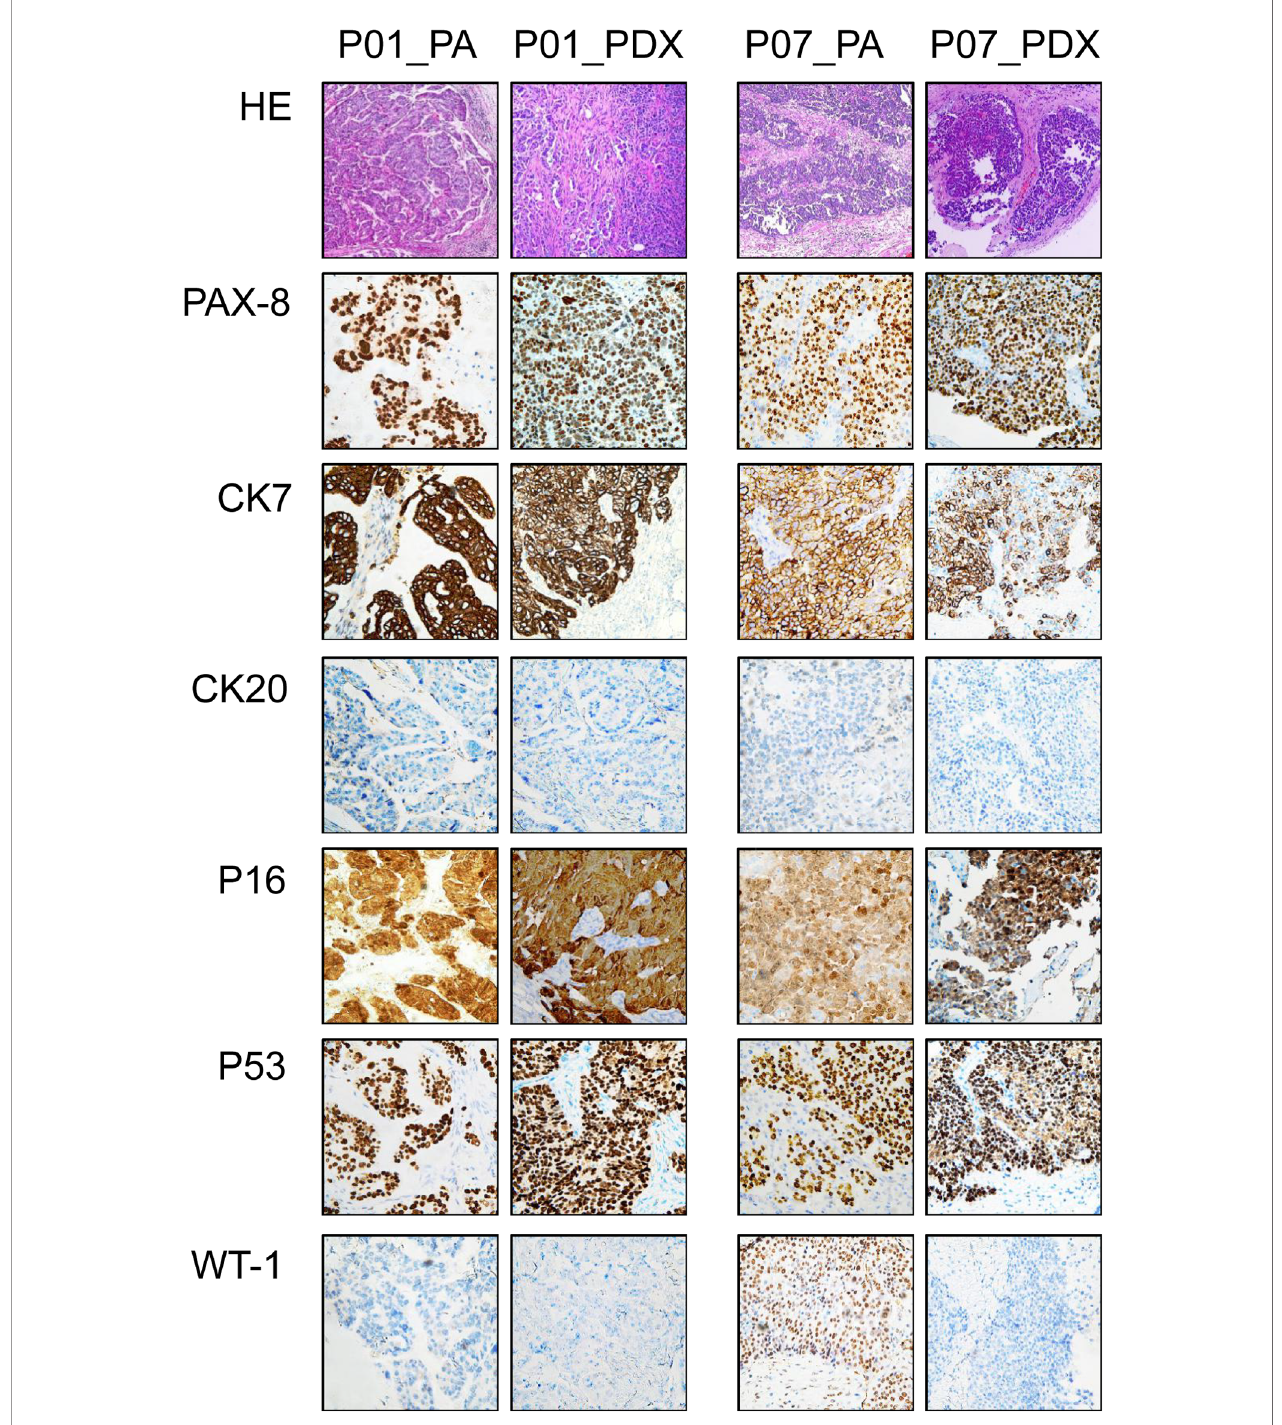
FIGURE 2 | Representative immunohistochemical appearances of PA and PDX tumors. This fi gure shows immunohistochemical results of paired samples from PA of P01 and P07 patients (both high-grade serous ovarian cancer) and the corresponding PDX models. Primary antibodies used in immunohistochemistry are labeled on the left. PA, patient tumor; PDX, patient-derived